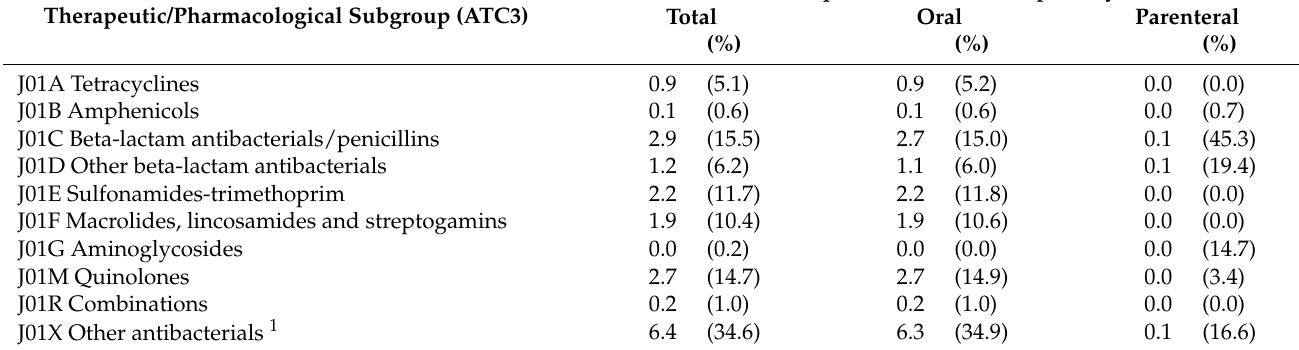
Table 1. Total antibiotic consumption (J01) per defined daily dose (DDD) per 1000 inhabitants per day according to the anatomical, therapeutic, and chemical (ATC level 3) classification system, by route of administration, in Sierra Leone, 2017–2019.